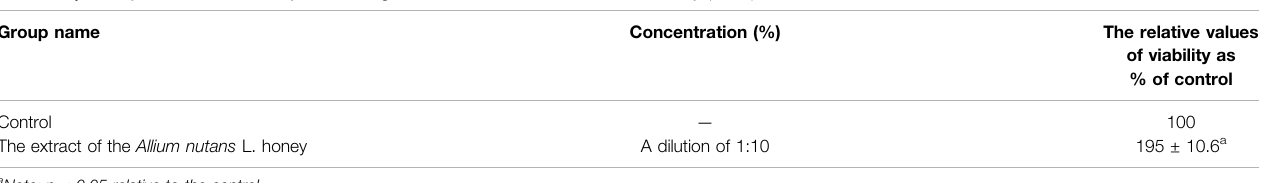
TABLE 5 | Viability of hFF in MTT assay when using the extract of the Allium nutans L. honey ( n (cid:2) 5).